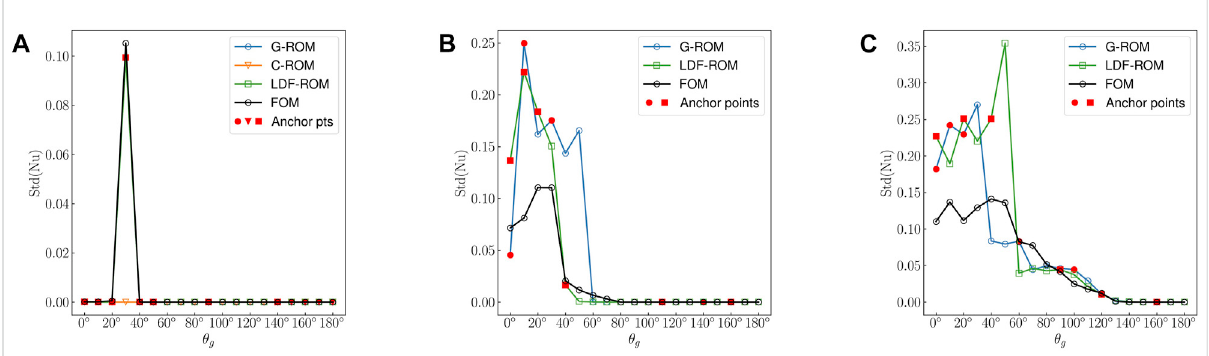
FIGURE 7 Behavior of the predicted Std(Nu) with θ g . (A) : G-ROM, C-ROM and LDF-ROM estimation at Ra = 1 × 10 4 with eight anchor points. (B) : G-ROM and LDF-ROM estimation at Ra = 8 × 10 4 with six anchor points. (C) : G-ROM and LDF-ROM estimation at Ra = 3 × 10 5 with six anchor points.